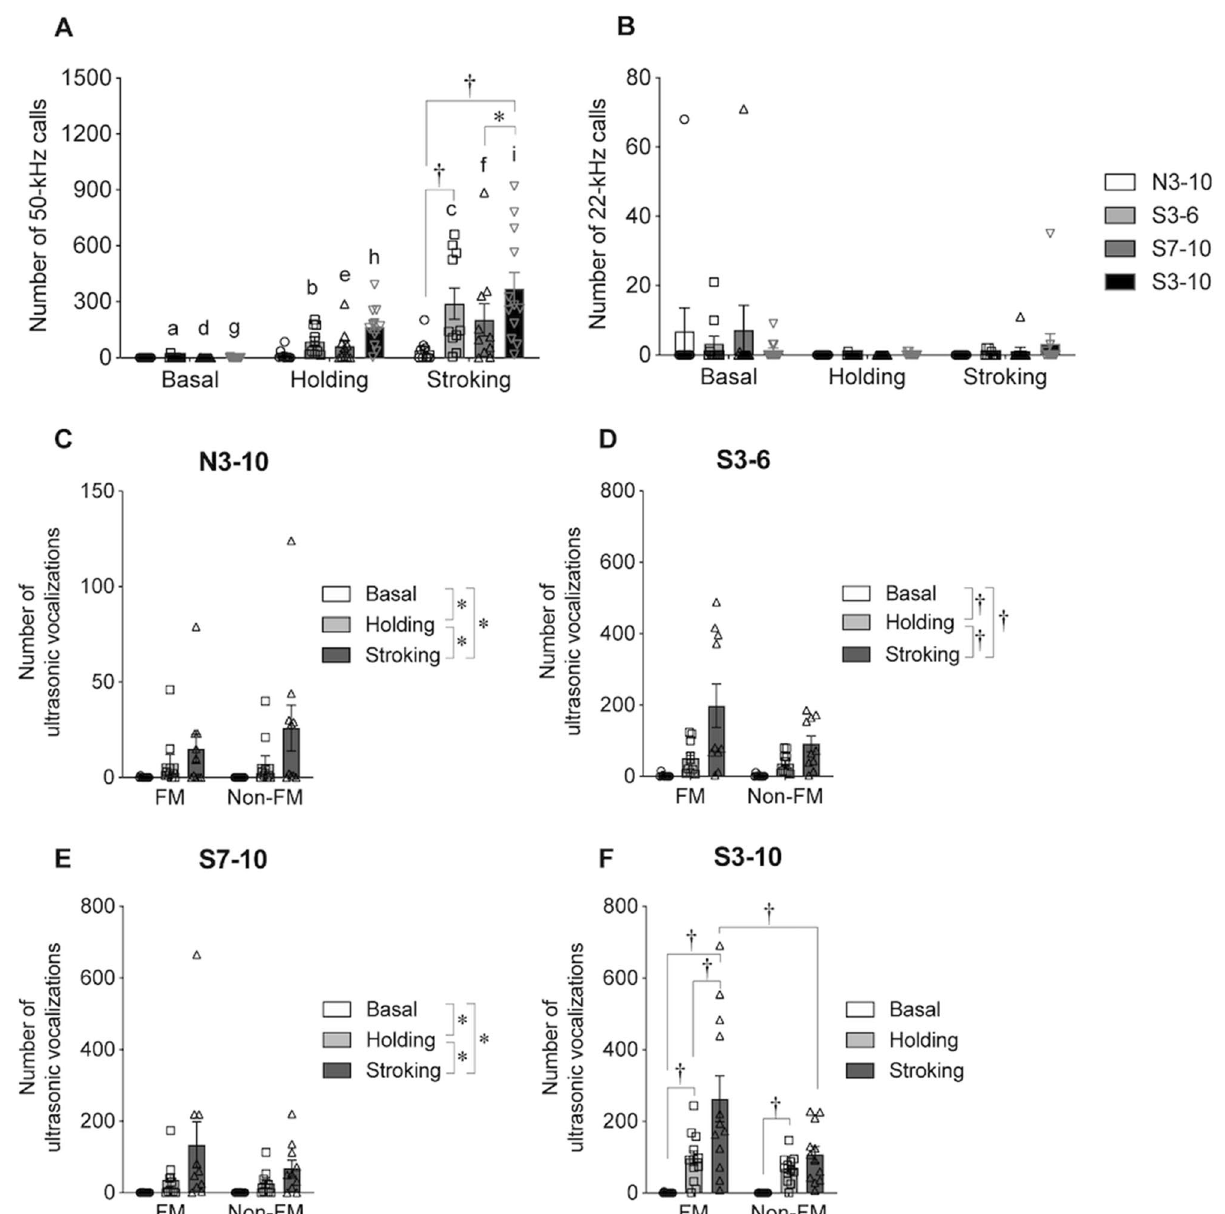
Figure 4. Numbers of ultrasonic vocalizations. ( A ) Number of 50-kHz calls. ( B ) Number of 22-kHz calls. The numbers of 50-kHz calls were significantly larger in the stroking condition than in the basal and holding conditions in the S3-6, S7-10, and S3-10 groups. In addition, in the S3-6, S7-10, and S3-10 groups, the numbers of 50-kHz calls were significantly larger in the holding condition than in the basal condition. In a group comparison, the numbers of 50-kHz calls in the stroking condition in the S3-6 and S3-10 groups were significantly larger than the number in the N3-10 group. The number of 50-kHz calls in the stroking condition in the S3-10 group was significantly larger than that in the S7-10 group. The numbers of 22-kHz calls were not significantly different in the basal, holding, and stroking conditions. ( C – F ) Numbers of FM and non-FM calls in the N3-10 ( C ), S3-6 ( D ), S7-10 ( E ), and S3-10 ( F ) groups. In the N3-10, S3-6, and S7-10 groups, the numbers of calls in the stroking condition were significantly larger than those in the basal or holding condition. The number of calls in the holding condition was significantly larger than that in the basal condition. In the S3-10 group, the number of FM calls in the stroking condition was significantly larger than those in the basal and holding conditions. In addition, the number of FM calls was significantly larger than the number of non-FM calls in the stroking condition. The number of non-FM calls in the holding condition was significantly larger than that in the basal condition. †, P < 0.01; *, P < 0.05. a vs. b, P < 0.01; a vs. c, P < 0.01; b vs. c, P < 0.01; d vs. e, P < 0.05; d vs. f, P < 0.05; e vs. f, P < 0.05; g vs. h, P < 0.01; g vs. i, P < 0.01; h vs. i, P < 0.01. A comparison was conducted by repeated measures two-way ANOVA (group × condition) or (syllable pattern × condition) followed by post-hoc Holm’s test. Error bars denote standard error of the